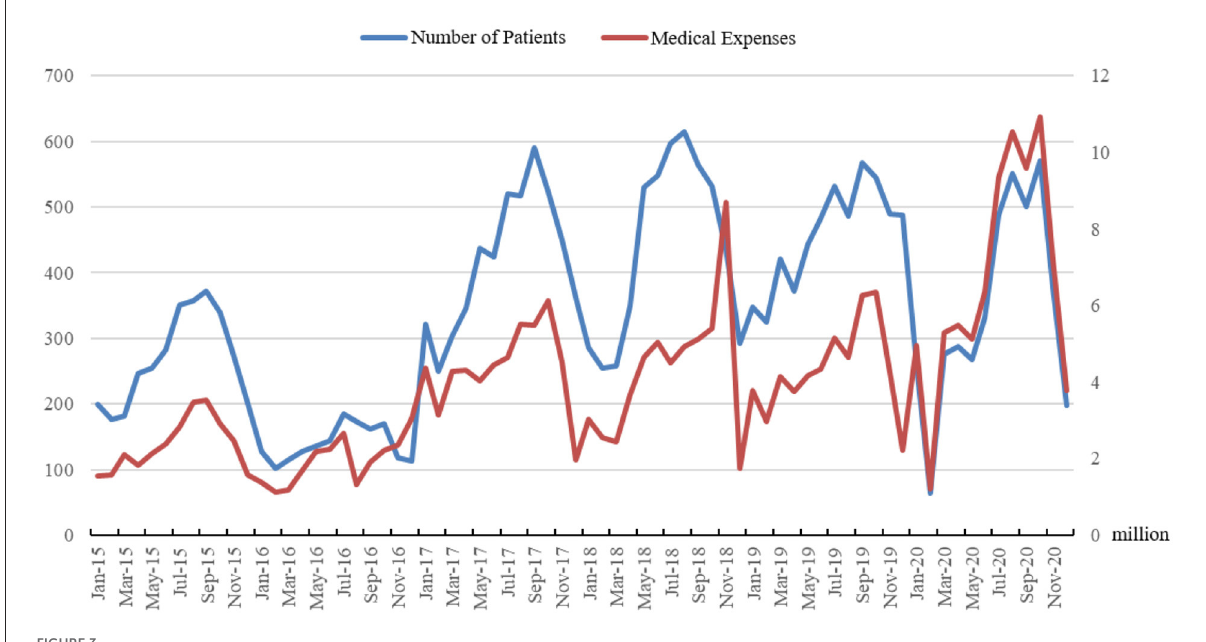
FIGURE3 Number and healthcare expenditure of RTIs inpatients for the period